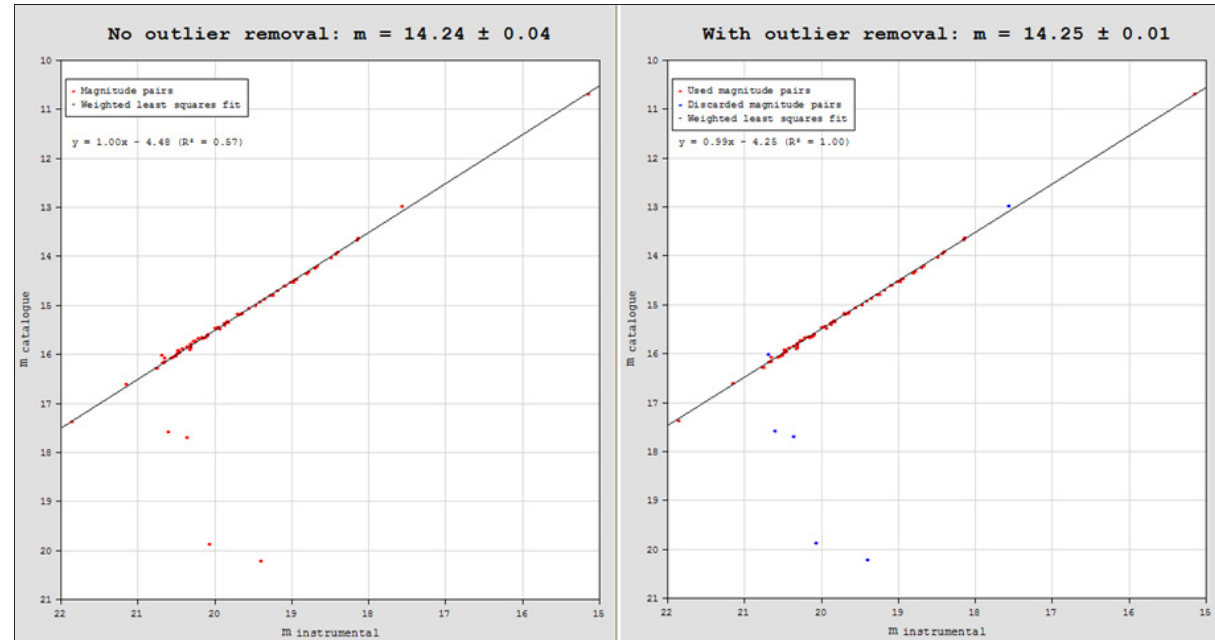
Figure 2: Calibration graphs for SXP11.5 showing the calibrated magnitudes, before (left) and after (right) outlier